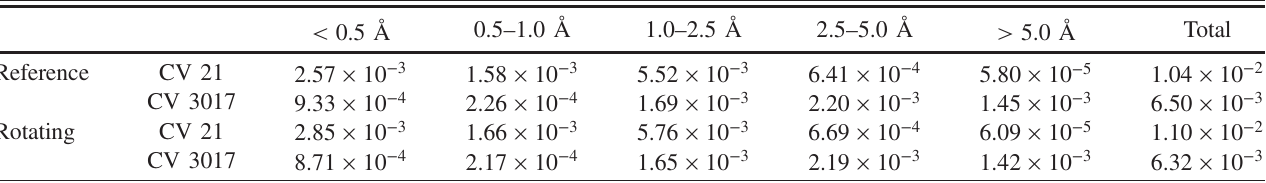
TABLE III. Neutron flux in n = ð cm 2 p Þ calculated in the two control volumes for the reference and rotating proton beams. The relative error of the values is below 1%.